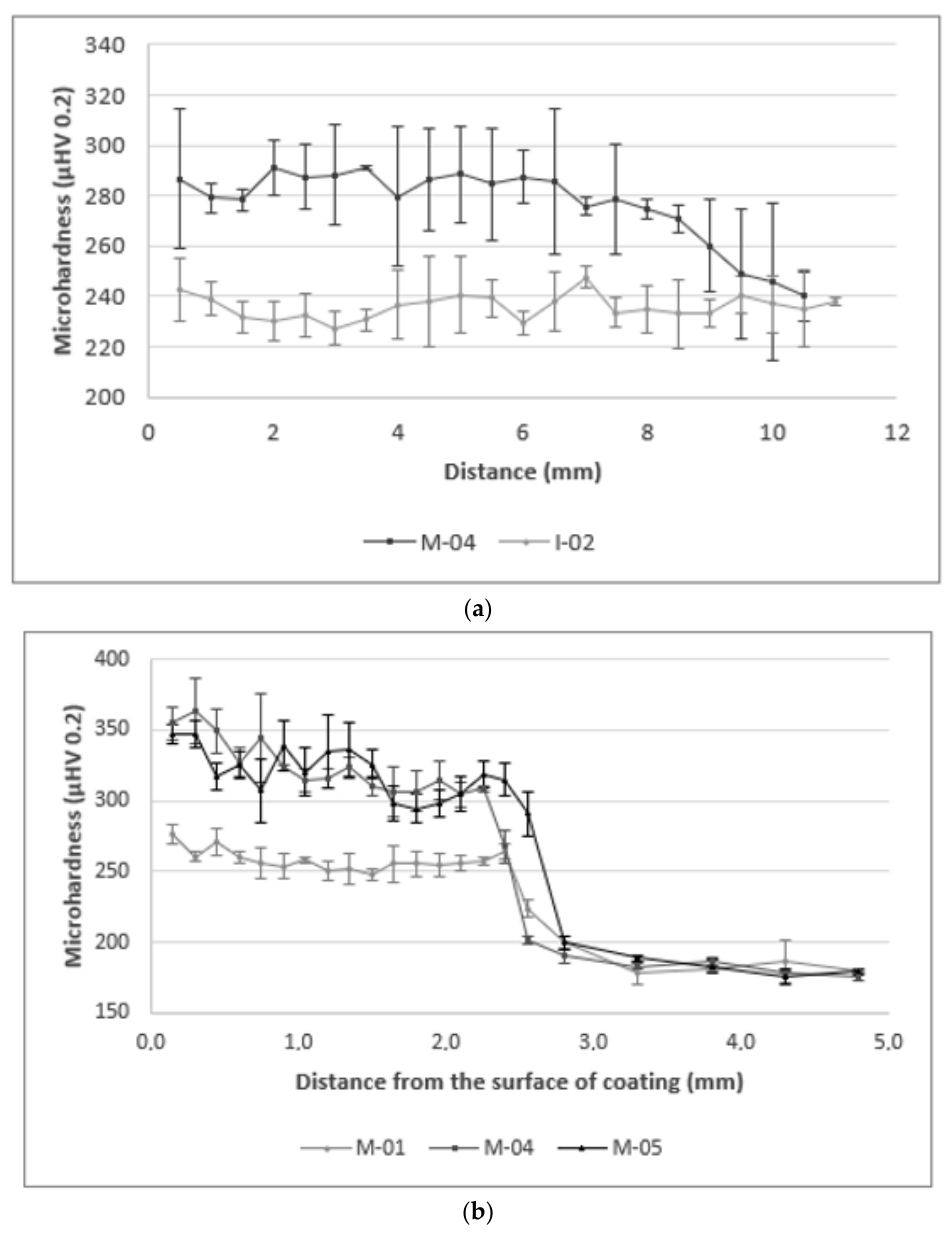
Figure 11. The Vickers microhardness distribution of the coatings; ( a ) across the subsequent beads according to Figure 1a, ( b ) from the surface to the base material according to Figure 1b (coatings designation according to Table 3).